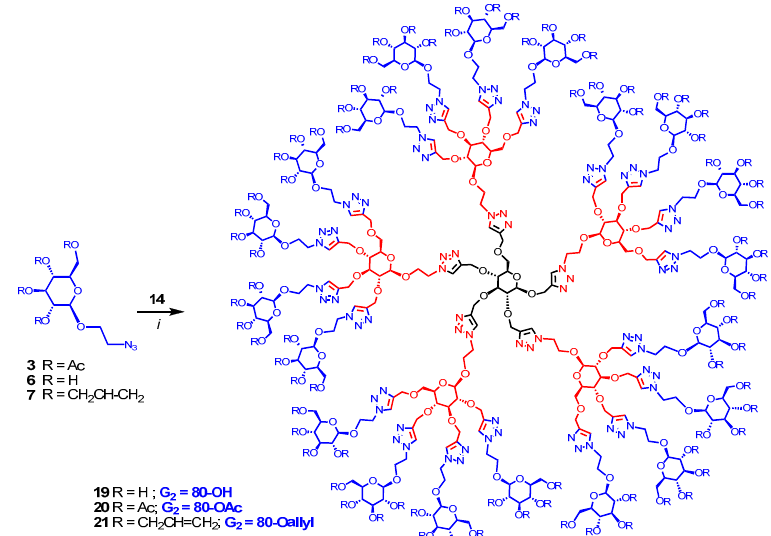
Figure 2. The MD simulation of 16 , starting from an initially fully extended conformation. Dendrimer 16 rapidly rearranges into a 2 nm stable globular shape in water.